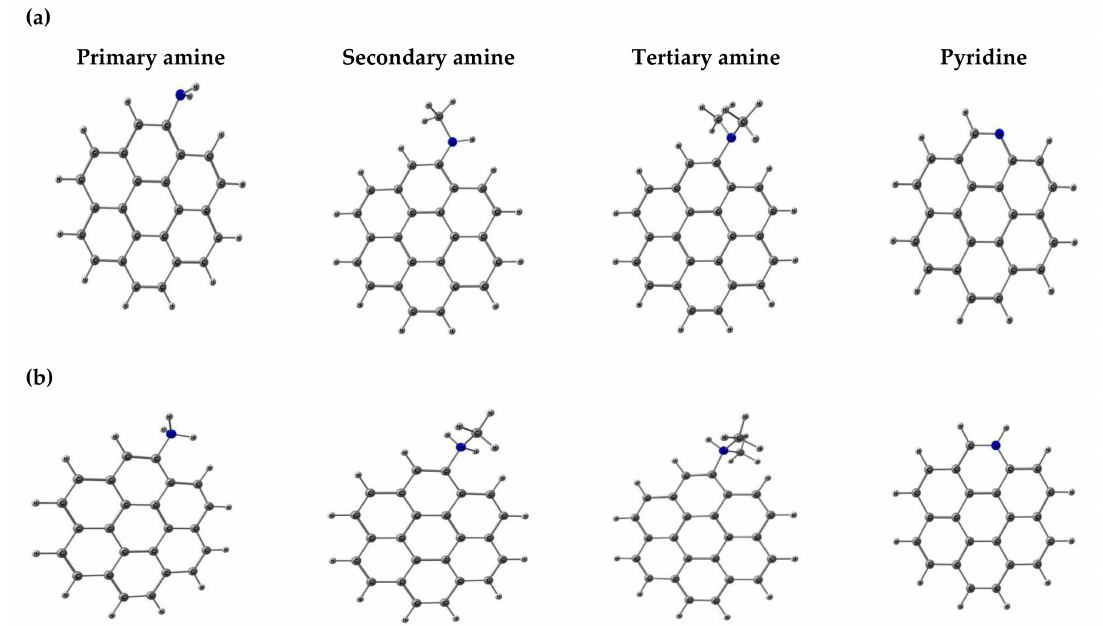
Figure 1. Activated carbon model for the molecular modelling studies: ( a ) nitrogen surface groups and, ( b ) protonate nitrogen surface